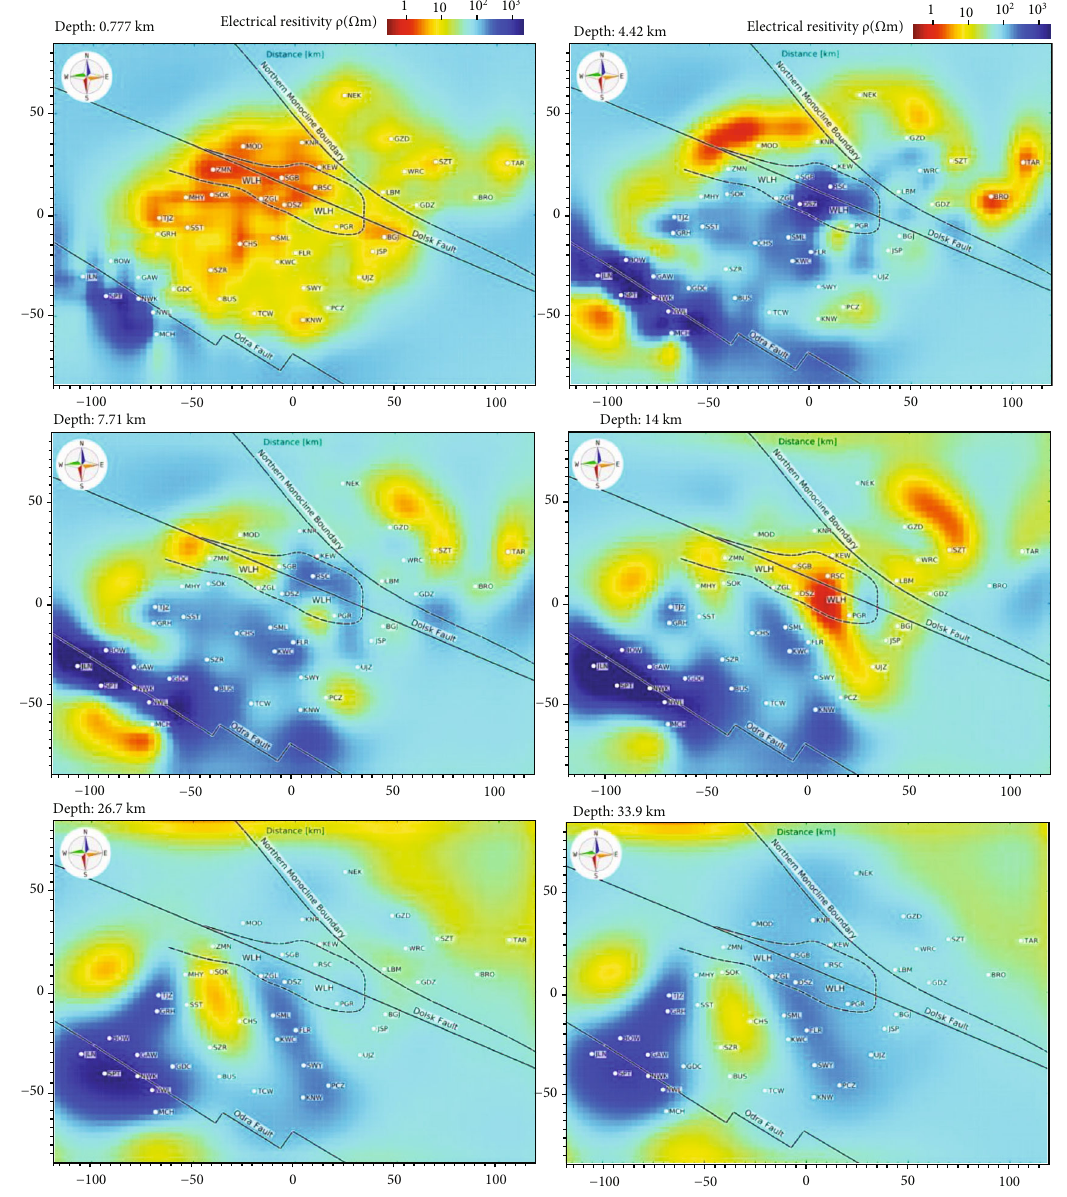
Figure 14: Presentation of 3D NLCG inversion results in depths ranging from 0 to 50 as depth sections for depths of 0.77, 4.42, 7.71, 14.0, 26.7, and 33.9